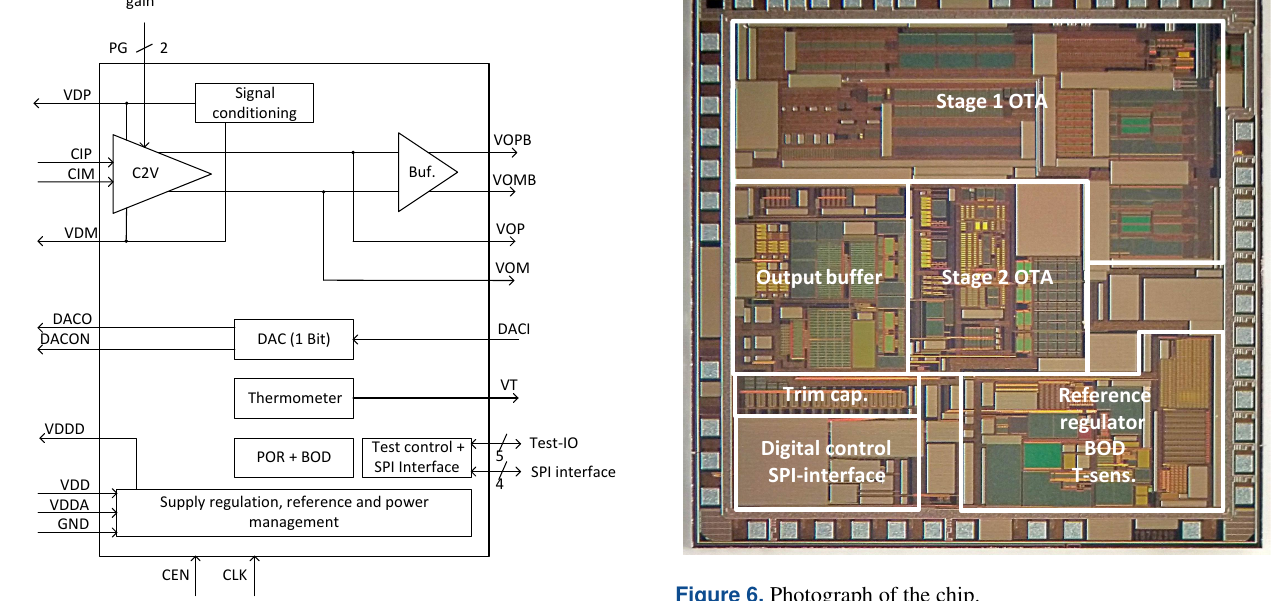
the externally supplied 5 V V DD . The integrated brown-out detection puts the chip into reset state if the supply voltage falls below a critical limit.